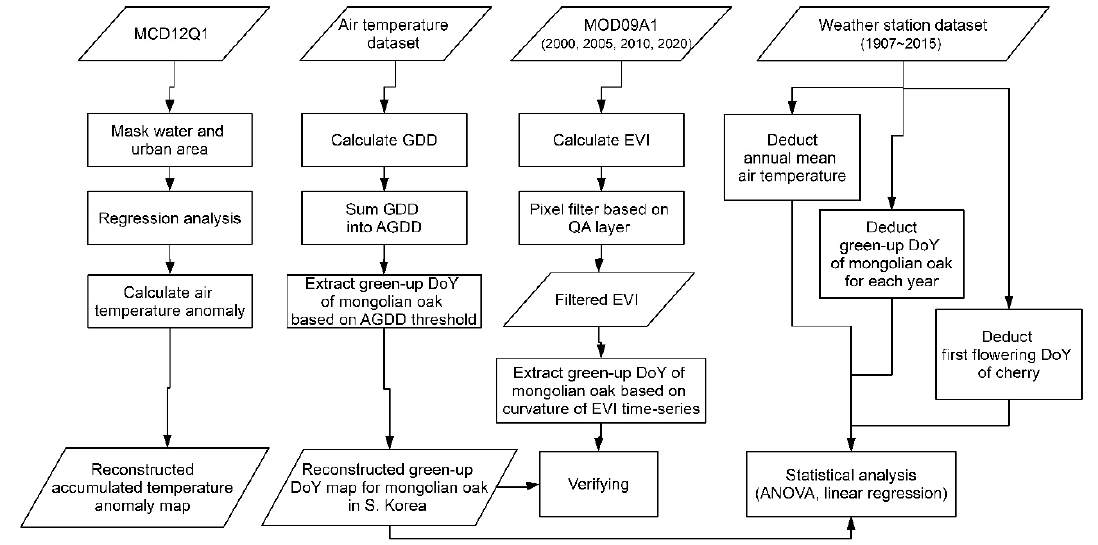
Figure 2. Flowchart showing the overall process of data processing and experiment.